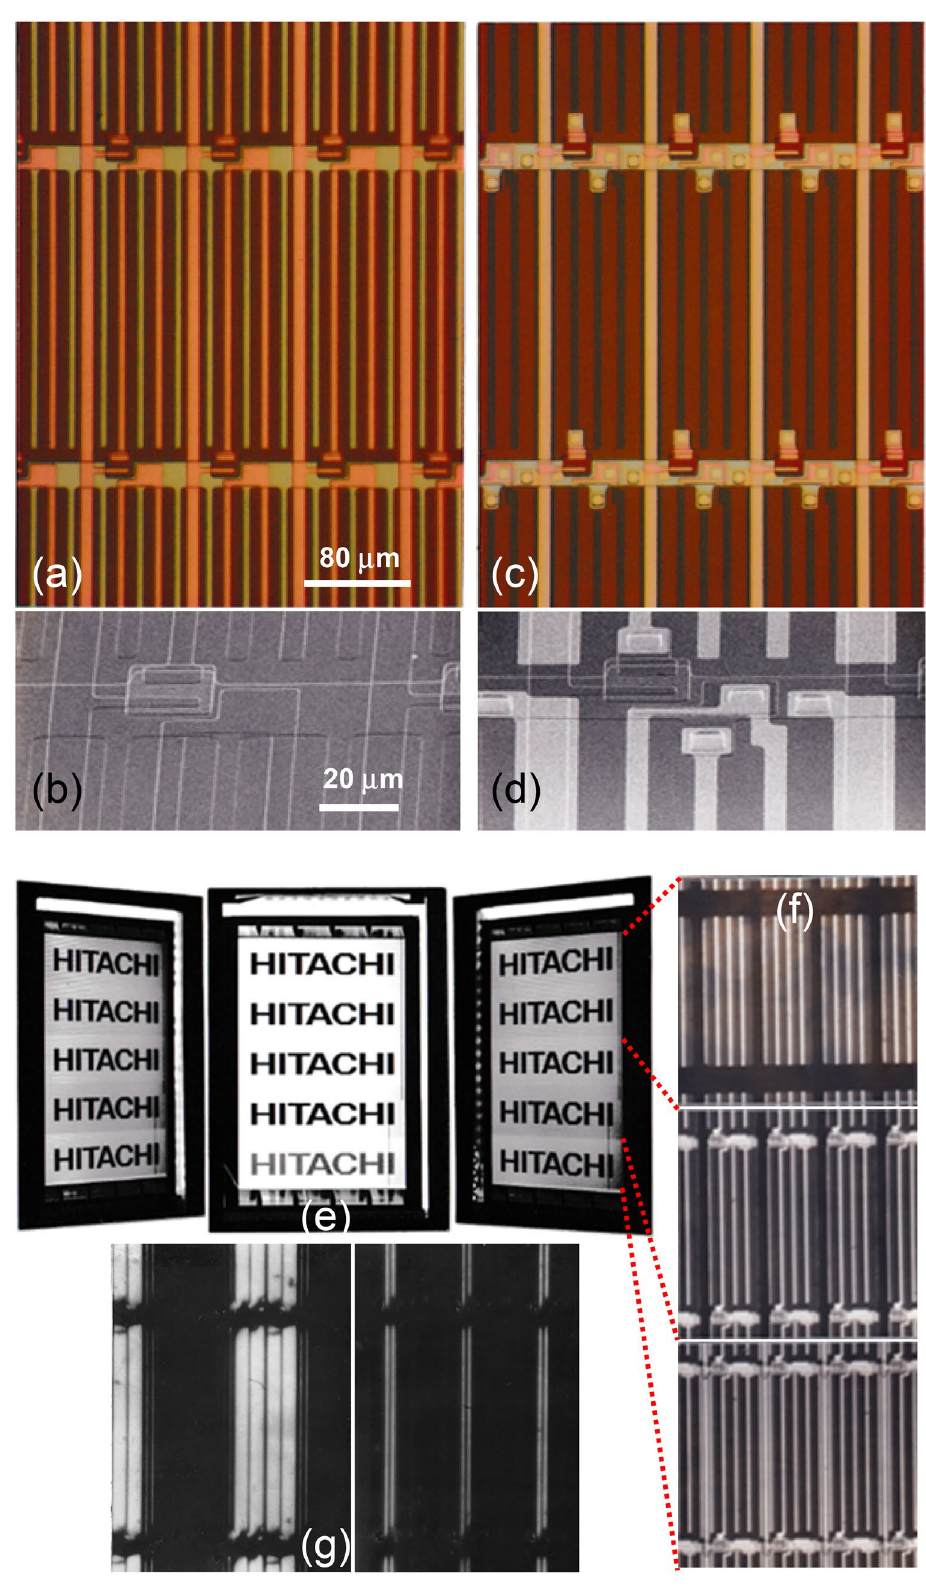
Figure 3. Optical and SEM (scanning electron microscopy) images of fabricated ( a , b ) CL and ( c , d ) CLSE pixel structures. The five white line patterns in ( d ) are the ITO interdigitated pixel and common electrodes. ( e ) Images from the normal direction and from 50 degrees to the left and right of a 2.3-inch-diagonal display incorporating the IPS TFT-LCD panel. ( f ) The three-black matrix (BM) patterns (top: BM covering both gate and data lines, middle: BM covering only the data lines, and bottom: without BM) and ( g ) optical images of pixels without BM (left: LC on and off voltages supplied to every other data line, right: LC off voltage supplied to all data